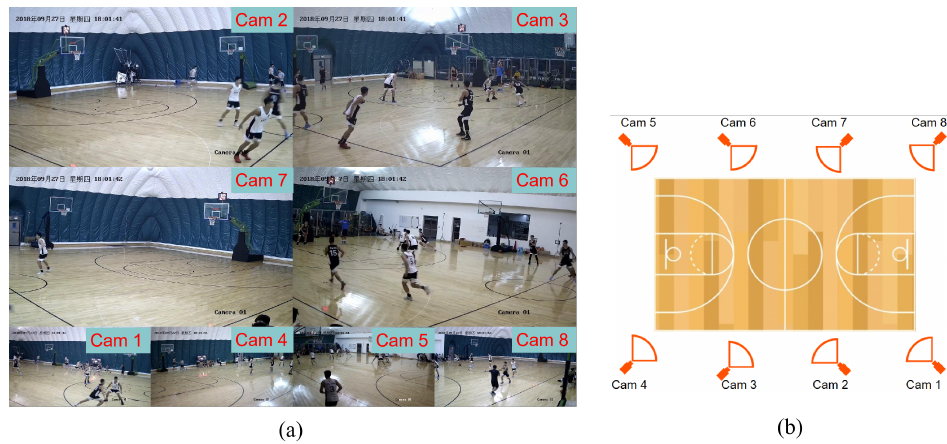
Figure 7. Our own STU basketball dataset is collected with eight ground cameras evenly distributed around the court: ( a ) images captured from eight views; ( b ) the schematic diagram of camera installation.